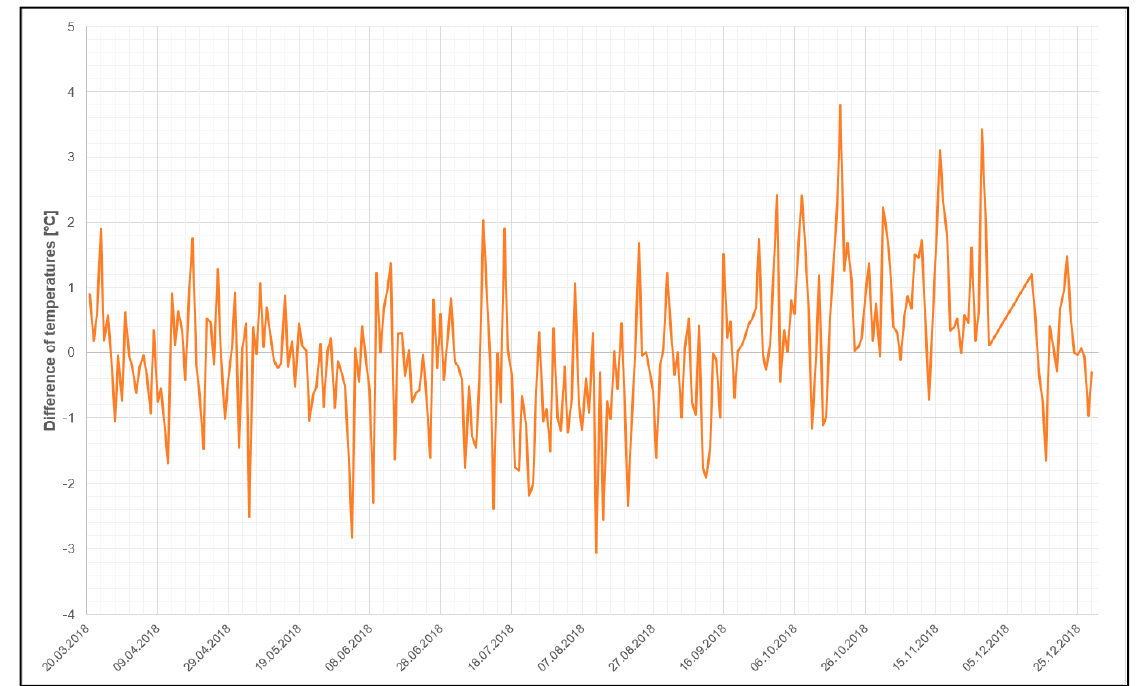
Figure 7. Graph showing the differences between ERA5-Land data and in-situ observations.